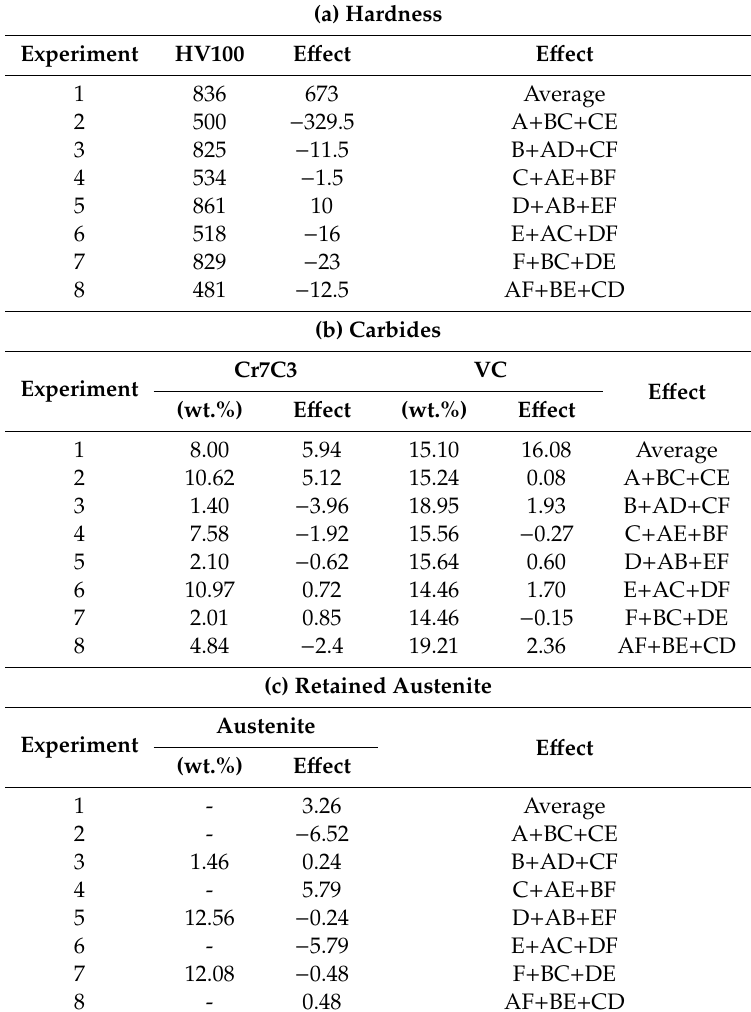
Table 5. Mean values and e ff ects obtained for the analyzed